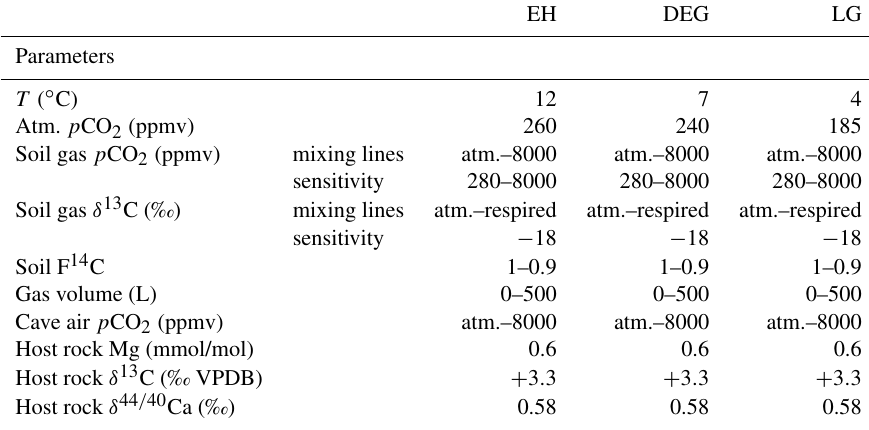
Table 1. Model initial parameters used for the mixing line simulations and sensitivity analysis. Model runs were repeated for each time slice (LG, DEG, EH). Details on the mixing line values can be found in Supplement Table S1. EH DEG